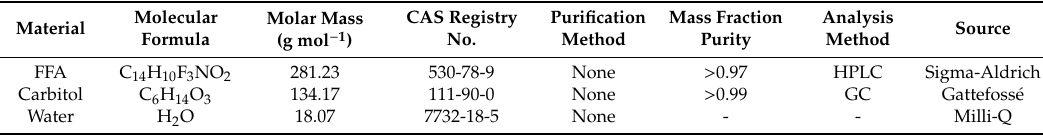
Table 1. A sample table for